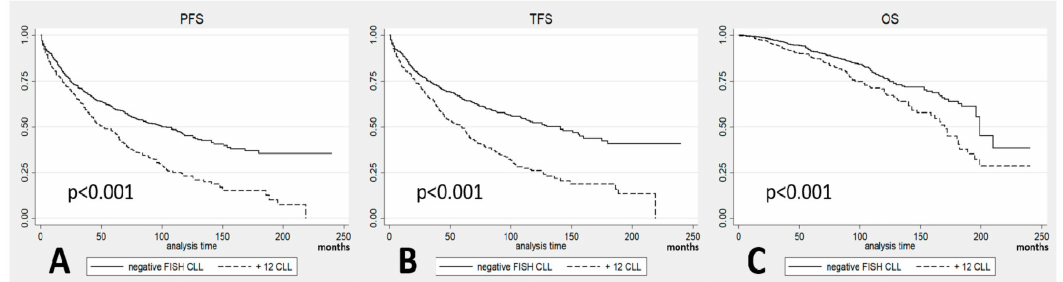
Figure 1. ( A ) Progression-free-survival (PFS) in patients with + 12 chronic lymphocytic leukemia (CLL) vs. fluorescence in situ hybridization (FISH) negative CLL; ( B ) treatment-free-survival (TFS) in patients with + 12 CLL vs. FISH negative CLL; ( C ) overall survival (OS) in patients with + 12 CLL vs. FISH negative